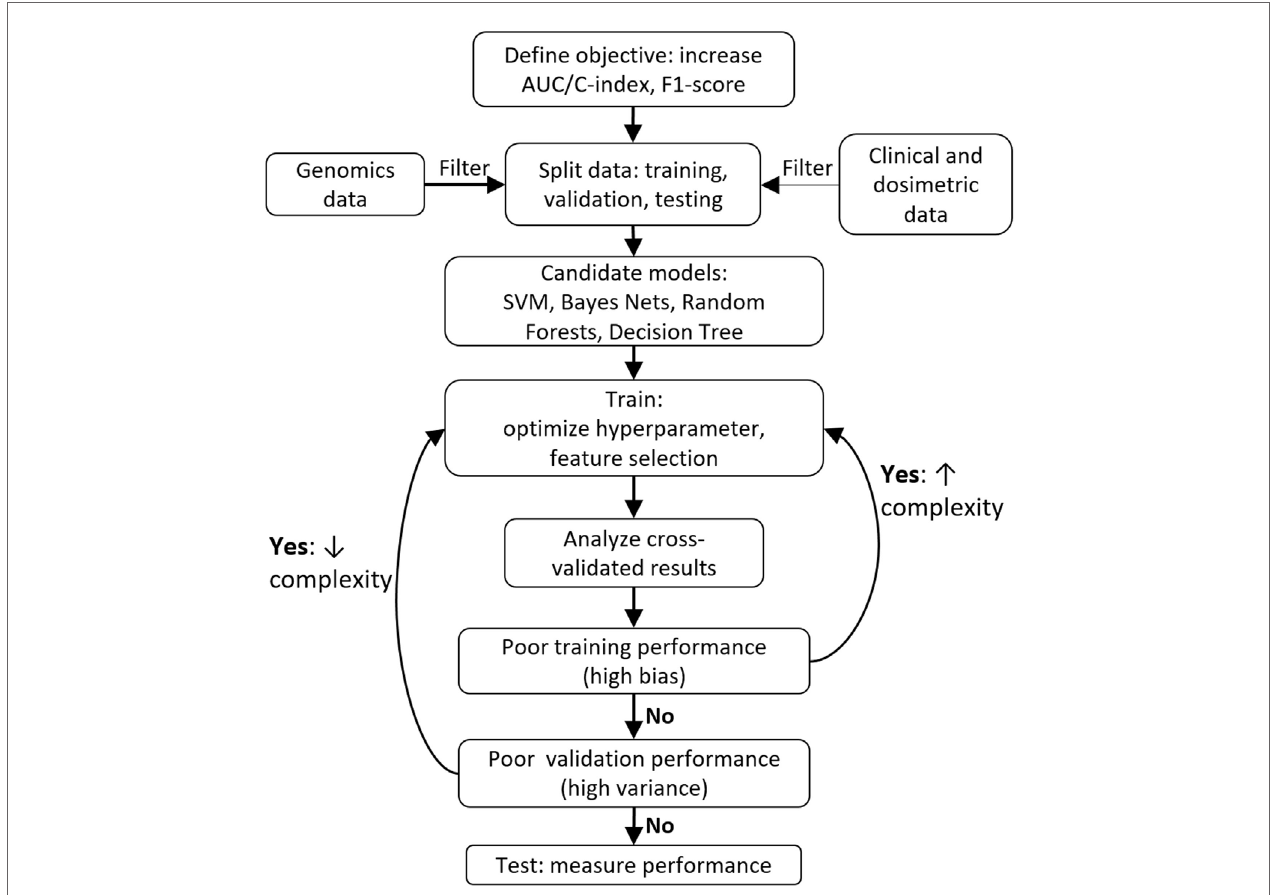
FiGURe 2 | Typical machine learning project